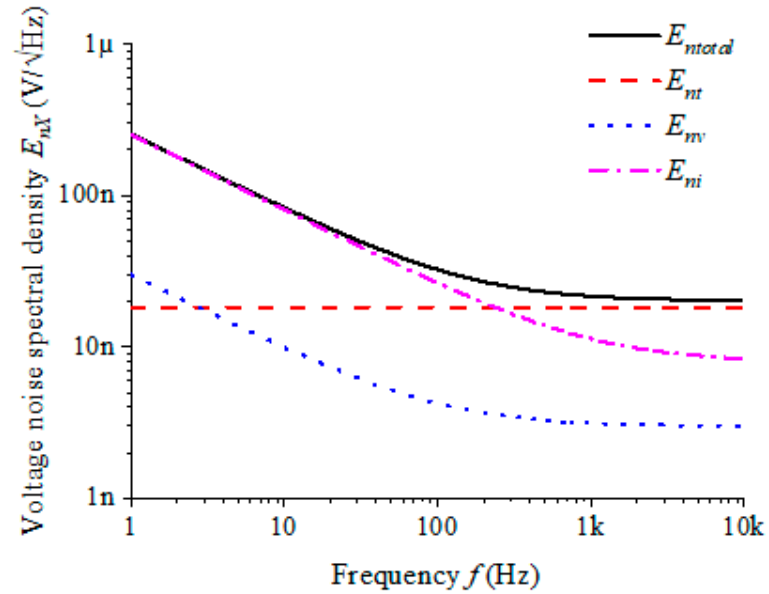
Figure 4. Each Noise contribution of the low-pass filter: E nfilter is the sum of all parts, E nt is the resistance thermal noise, E nv is the operational amplifier voltage noise and E ni is the current noise. The filter output total noise 𝐸 (cid:3041)(cid:2916)(cid:2919)(cid:2922)(cid:2930)(cid:2915)(cid:2928) is the sum of superposition of the resistance thermal noise 𝐸 𝐸 𝐸 (cid:3041)(cid:3047) , the operational amplifier voltage noise (cid:3041)(cid:3049) and the current noise (cid:3041)(cid:3036) . It is seen that the current noise of the op-amp contributes the most noise to the total output noise, especially in the range of 1/f noise. When the frequency f is equal to 1 Hz, 𝐸 (cid:3041)(cid:3033)(cid:3036)(cid:3039)(cid:3047)(cid:3032)(cid:3045) is 2.56 × 10 − 7 V/ √ Hz and 𝐸 (cid:3041)(cid:3036) is 2.53 × 10 − 7 V/ √ Hz. Hence in the design of low-pass filters, the choice of op-amps is critical.